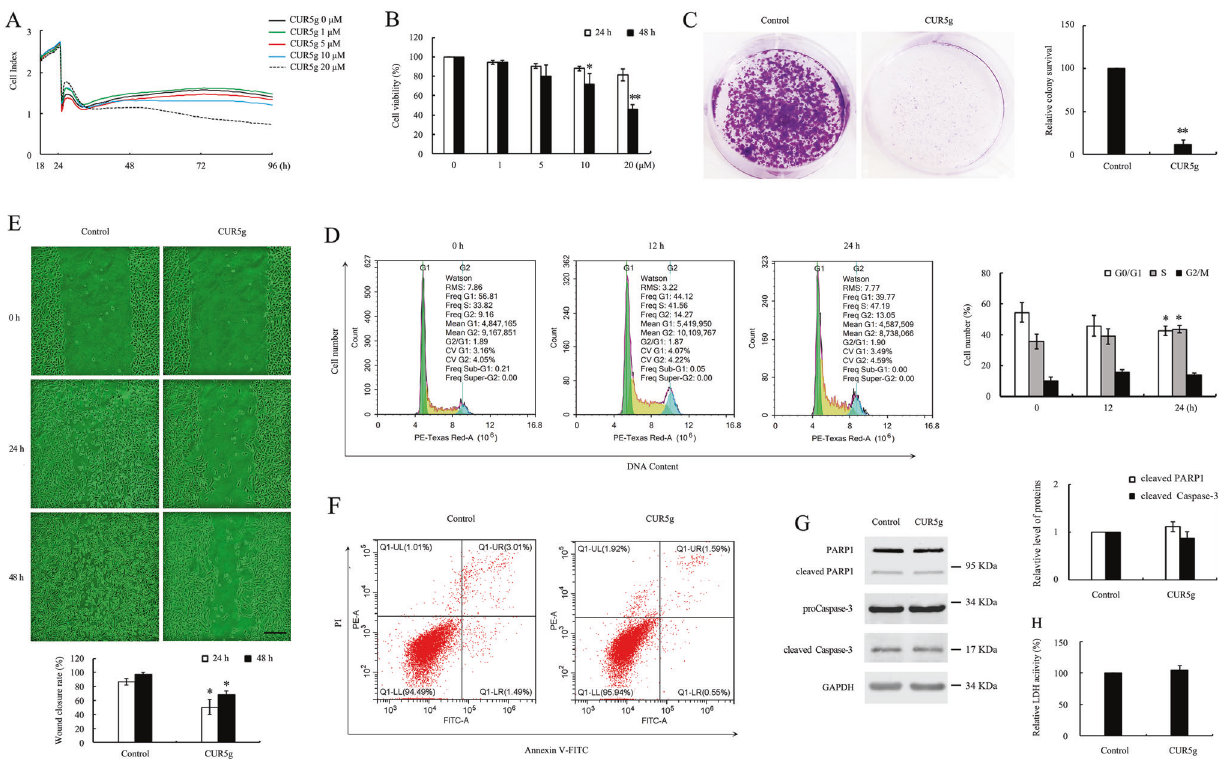
Fig. 6 CUR5g inhibited proliferation and migration of A549 cells, but did not induce apoptosis or necrosis. A Cell number was monitored over 96 h in a real-time manner using an xCELLigence RTCA S16 System. Cell-sensor impedance is displayed as the cell index. CUR5g (0 – 20 μ M) was added after the cells were seeded into the plates for 24 h. B MTT assays. C Representative images of colony formation assay of A549 cells treated with DMSO or CUR5g (10 μ M) for 12 days. At the end, the colonies were fi xed and stained with crystal violet. Histogram shows the relative colony survival. ( n = 3; ** p < 0.01 vs. Control). D Flow cytometric analysis of cell cycle in A549 cells treated with CUR5g (10 μ M) for 0, 12, or 24 h, respectively. E The effect of DMSO or CUR5g (10 μ M) on the migratory potential of A549 cells was analyzed through